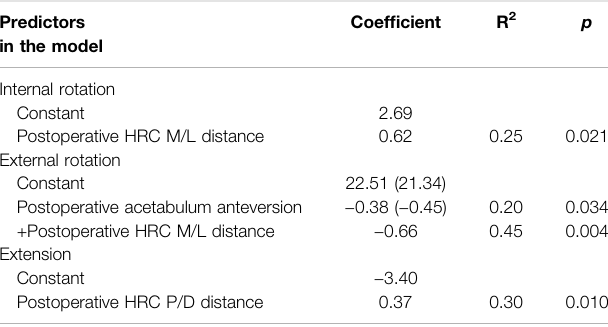
TABLE 3 | Coef fi cients, R 2 , and p values of the predictors identi fi ed by forward multiple liner regression analysis. Predictors in the